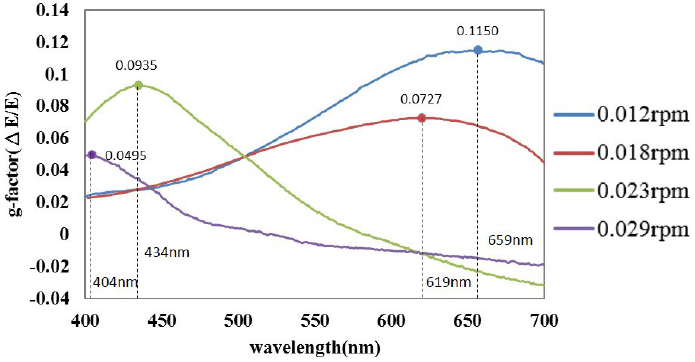
Figure 5. g ‐ factor spectra of samples deposited at 0.012 rpm, 0.018 rpm, 0.023 rpm, and 0.029 rpm.